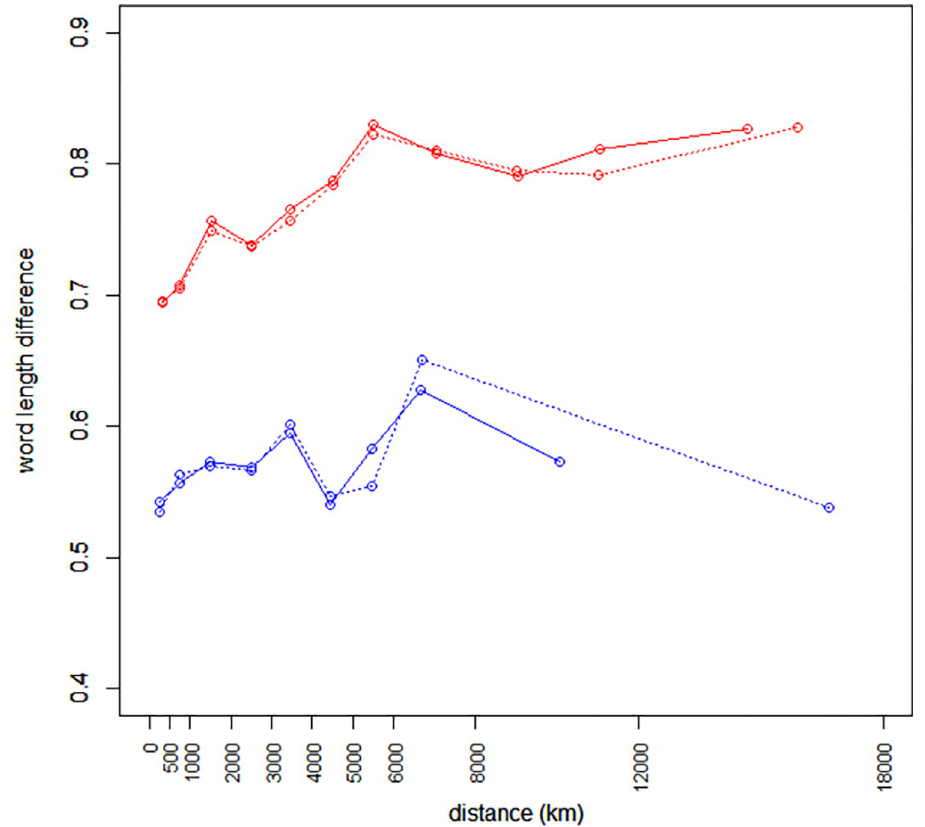
Fig 1. Word length difference as a function of geographical distance for unrelated (red lines) and unrelated (blue lines) languages, using the Great Circle Distance (solid lines) and an approximate walking distance (dotted lines). For both variables the means within bins are